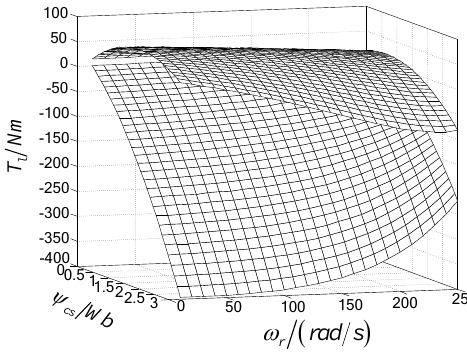
Figure 10. Maximum and minimum torque curve surfaces of a BDFM.